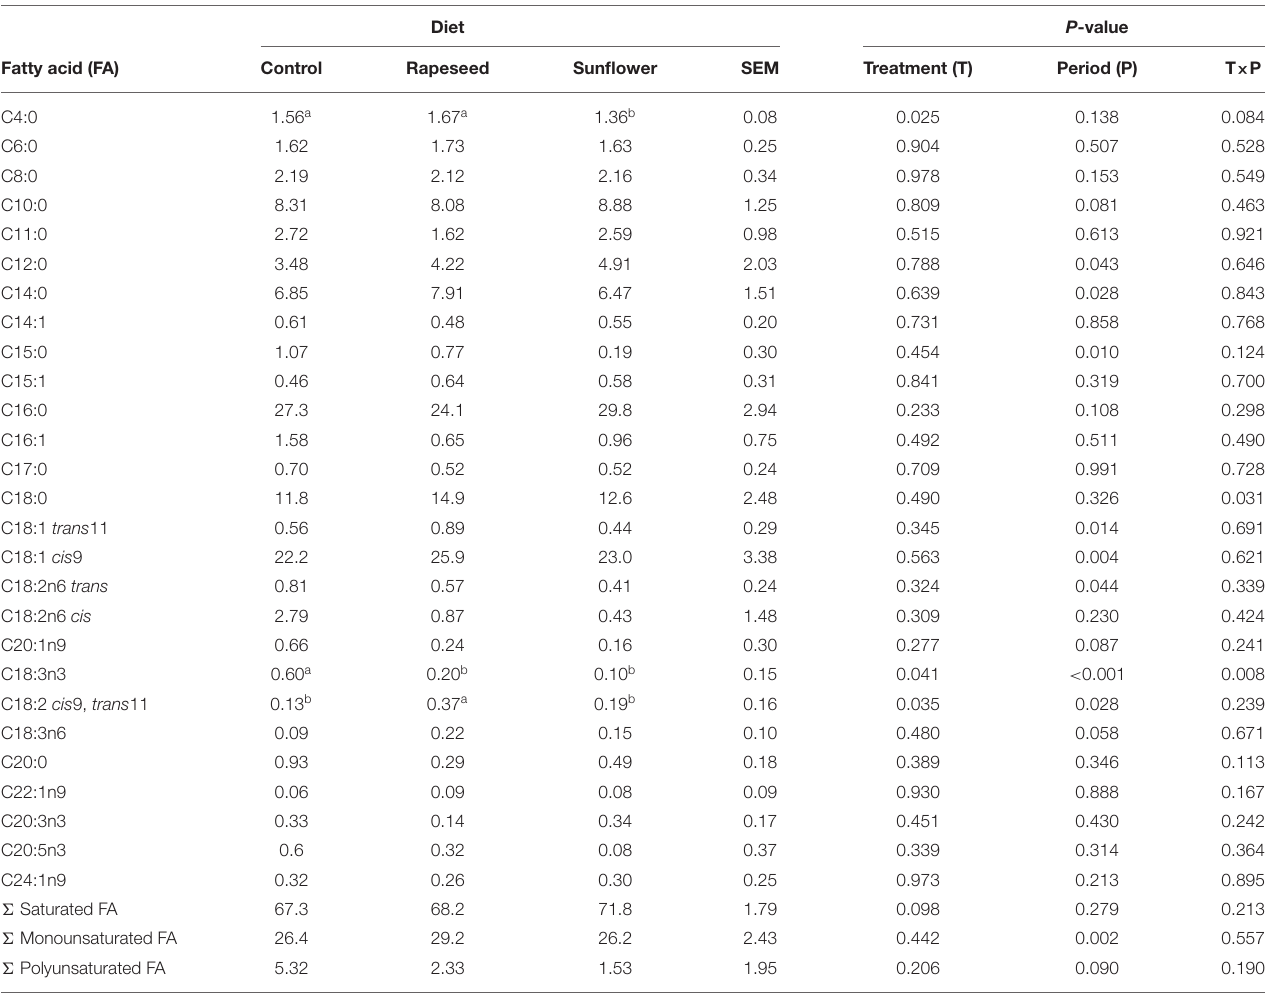
TABLE 3 | Milk fatty acid profile from goats fed rapeseed oil and sunflower oil (g/100g of fatty acid methyl esters). Diet P